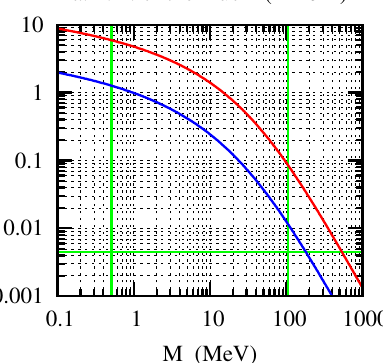
Figure 3. Contributions to the muon anomalous magnetic moment a of «anomalous leptons» of the mass M . Blue curves: «leptons» of spin 0. Red curves: «leptons» of spin 1 / 2. Vertical line corresponds the muon mass. Horizontal line marks the limit permitted by Eq. (1) for Δ